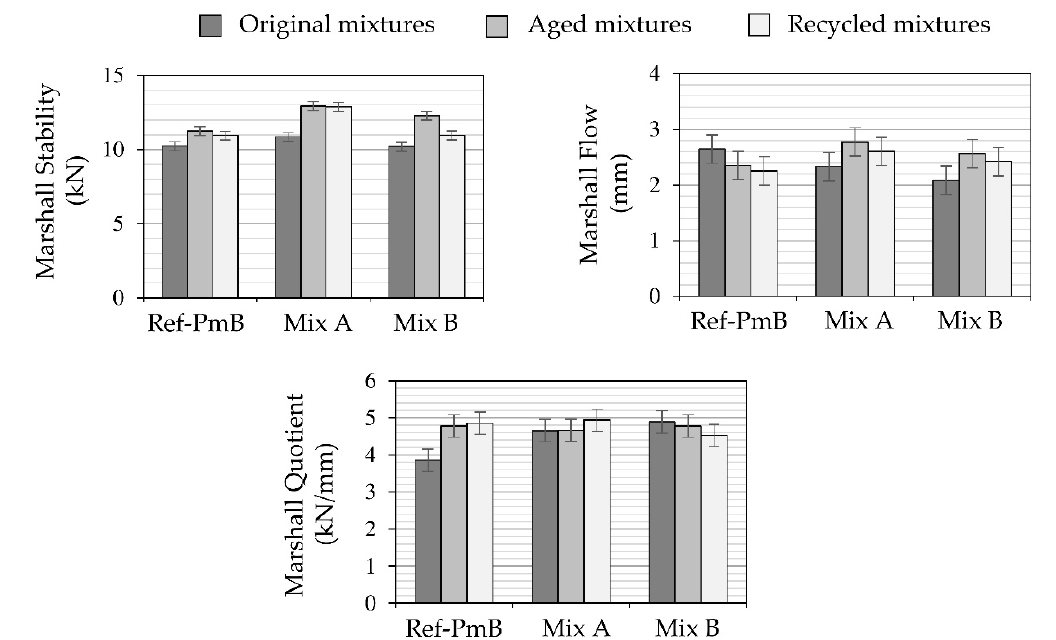
Figure 5. Marshall test results.